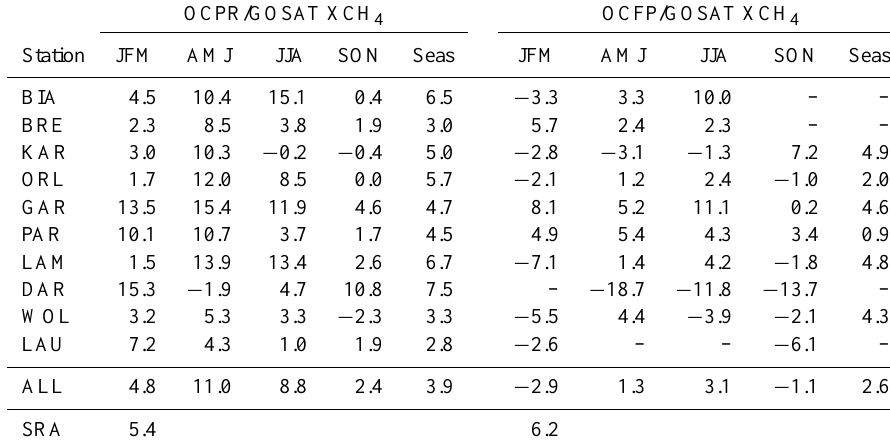
Table 11. OCPR and OCFP XCH 4 seasonal mean bias, seasonality and SRA results. All results are in ppb